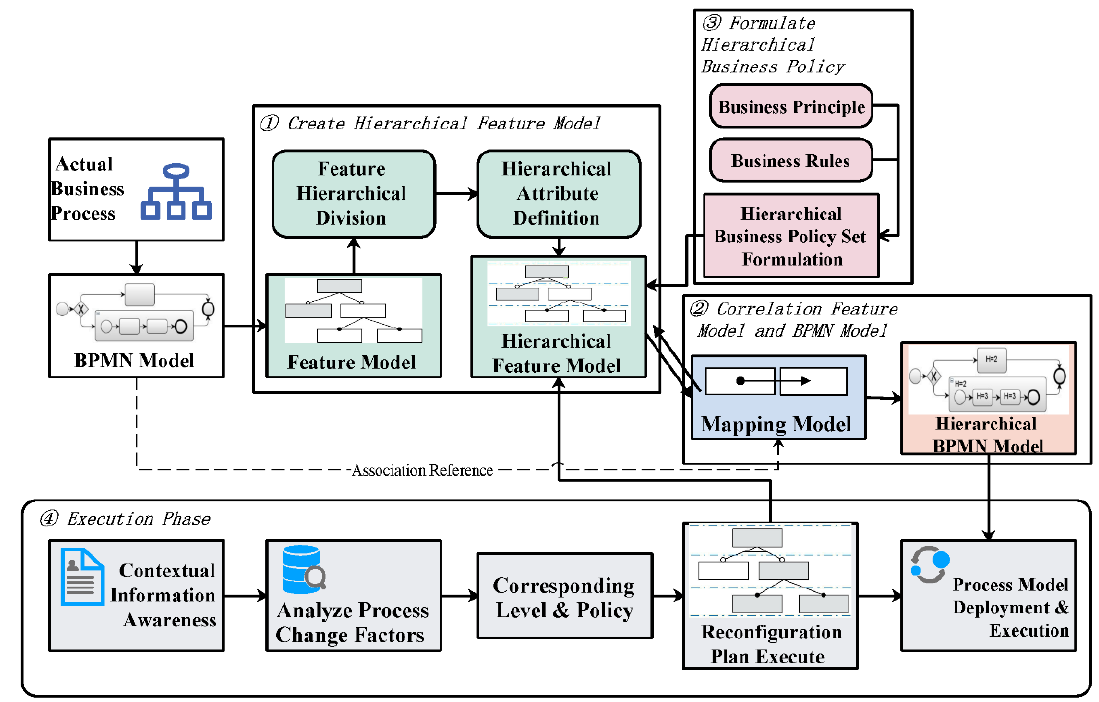
Figure 1. Overall framework of the HPMF method.